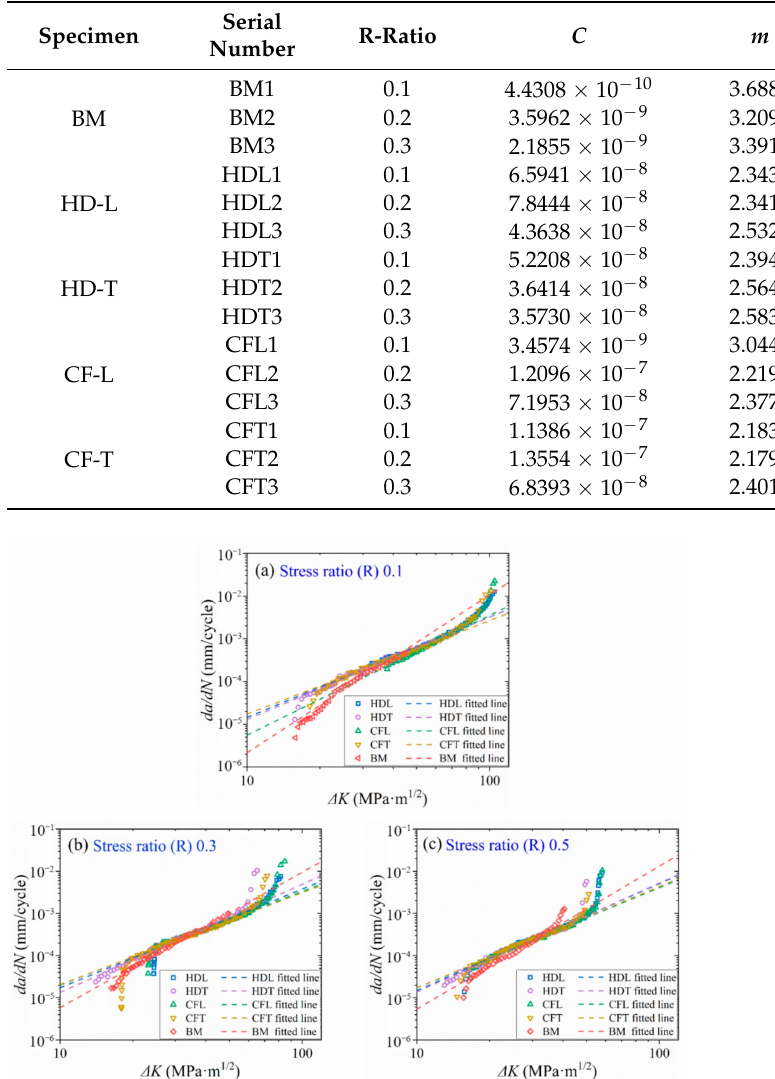
Table 3. Constants for the Paris model.